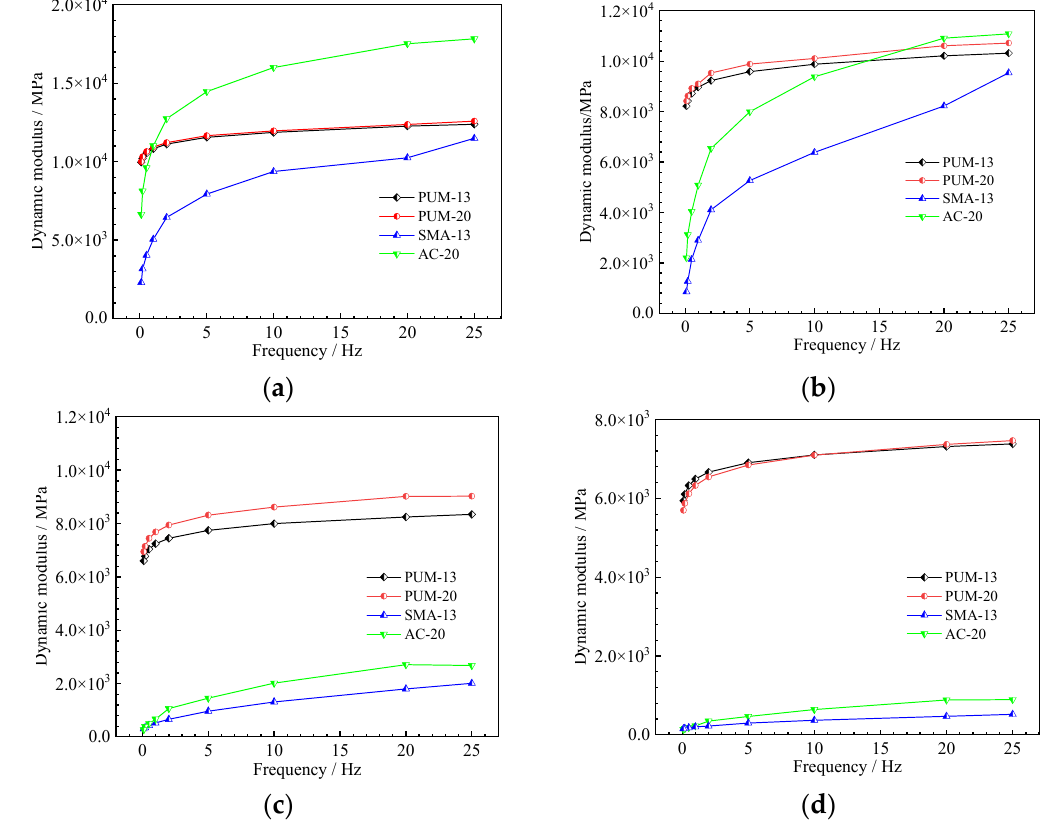
Figure 6. Dynamic modulus of the four mixtures. ( a ) 10 °C. ( b ) 20 °C. ( c ) 35 °C. ( d ) 50 °C.